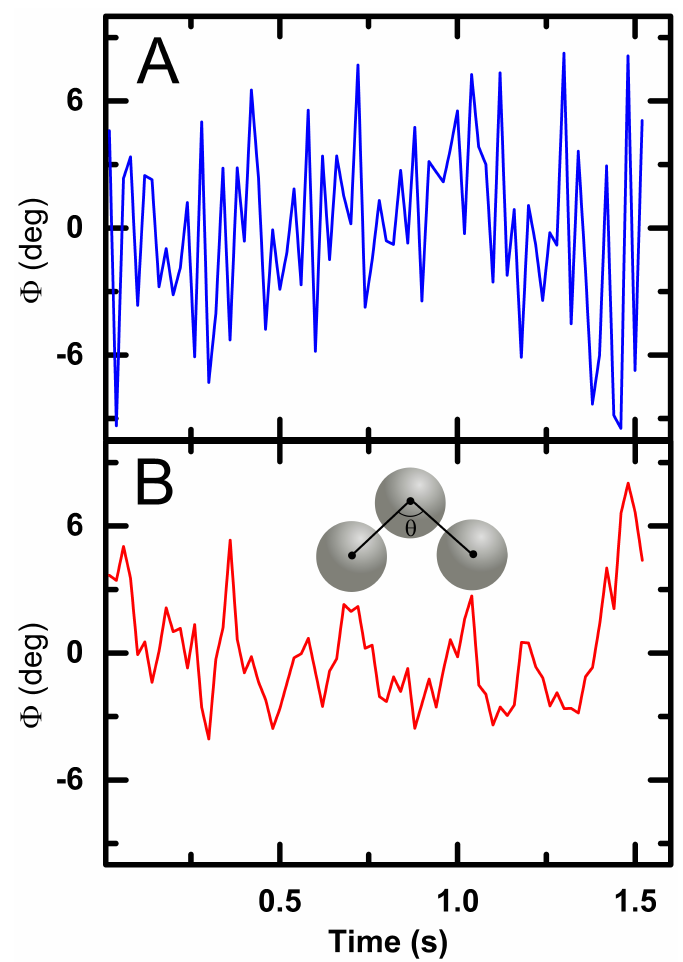
Figure 5. Bond angle fluctuations for samples of DP = 100 with 0.3% ( A ) and 3% ( B ) grafting density. The variance of the fluctuations are 6.7 (deg) 2 and 19.2 (deg) 2 respectively. Inset; schematic representation of bond angle calculation between neighboring